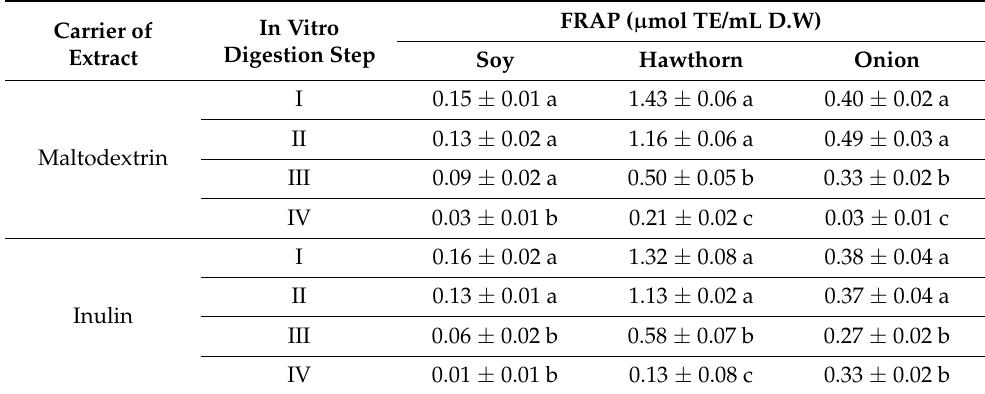
Table 5. FRAP antioxidant capacity ( µ mol TE/mL D.W.) of liquids released during in vitro digestion of wheat bread enriched with different